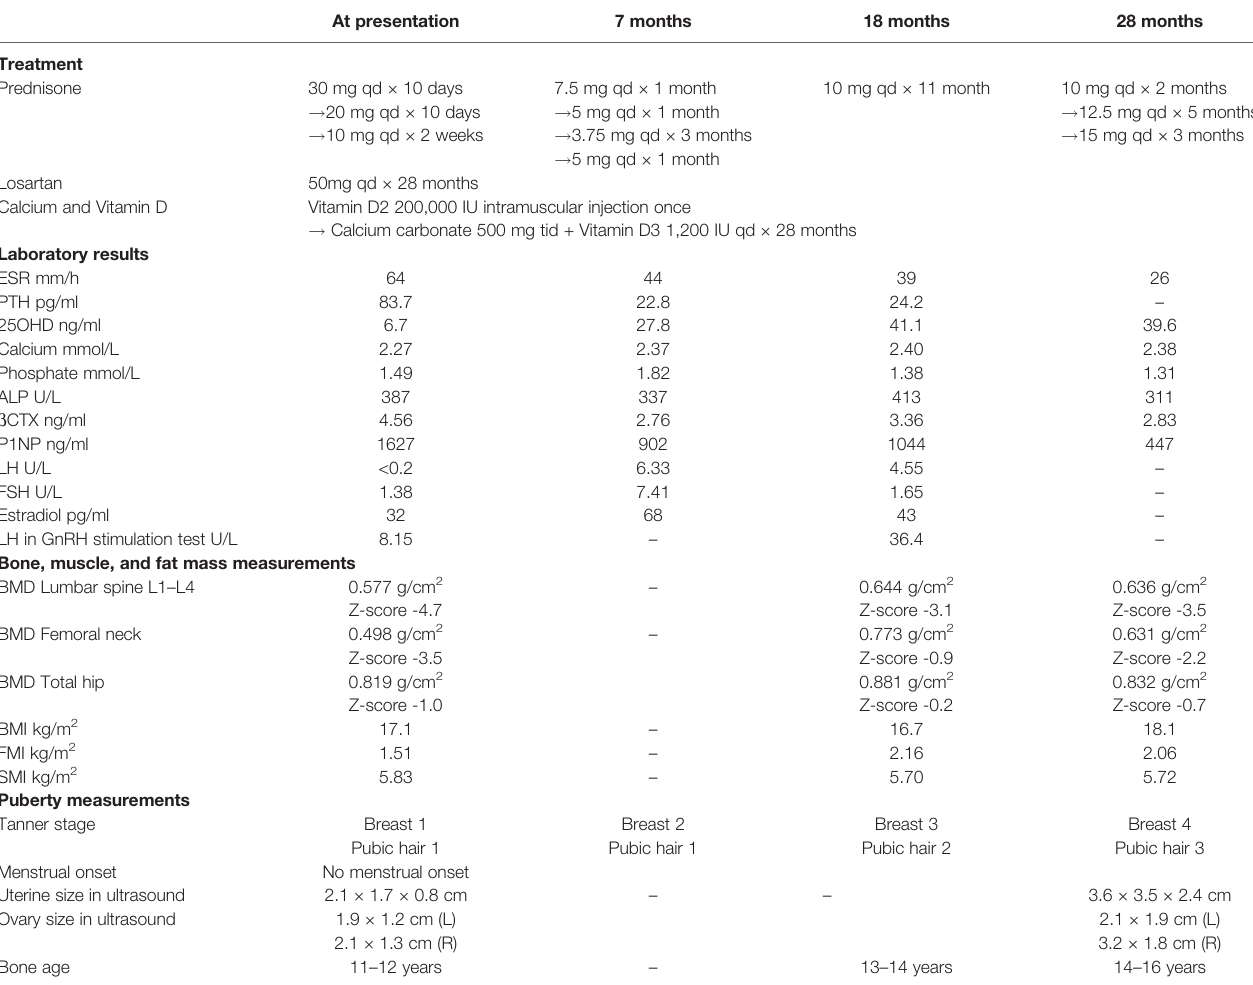
TABLE 1 | Demographic features of the patient with CED during 28-month follow-up. At